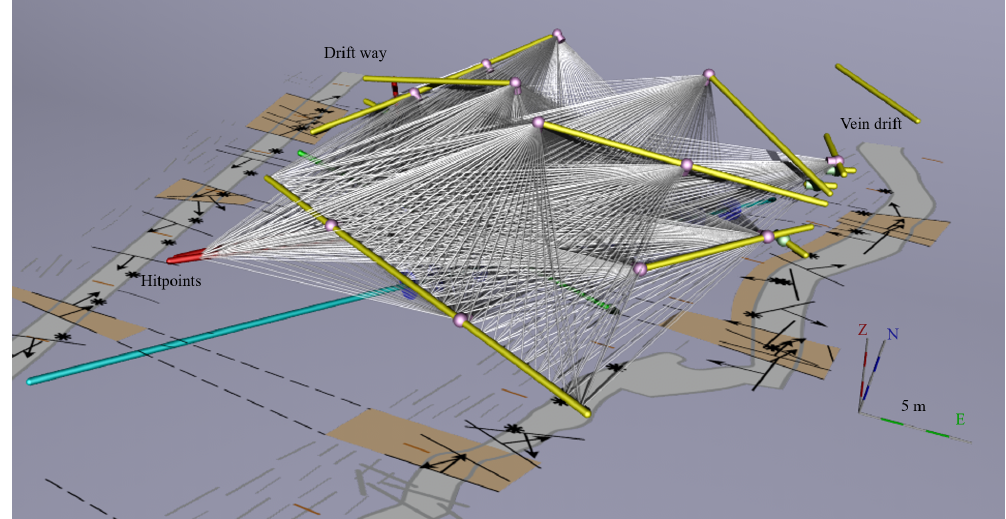
Figure 3. Overview of active seismic measurements within the STIMTEC volume; ray paths show coverage achieved using UT measurements from boreholes to sensors. See Fig. S3 for different 3-D views. Hit points (black stars) along the galleries mark positions of repeated active hammer and centre punch